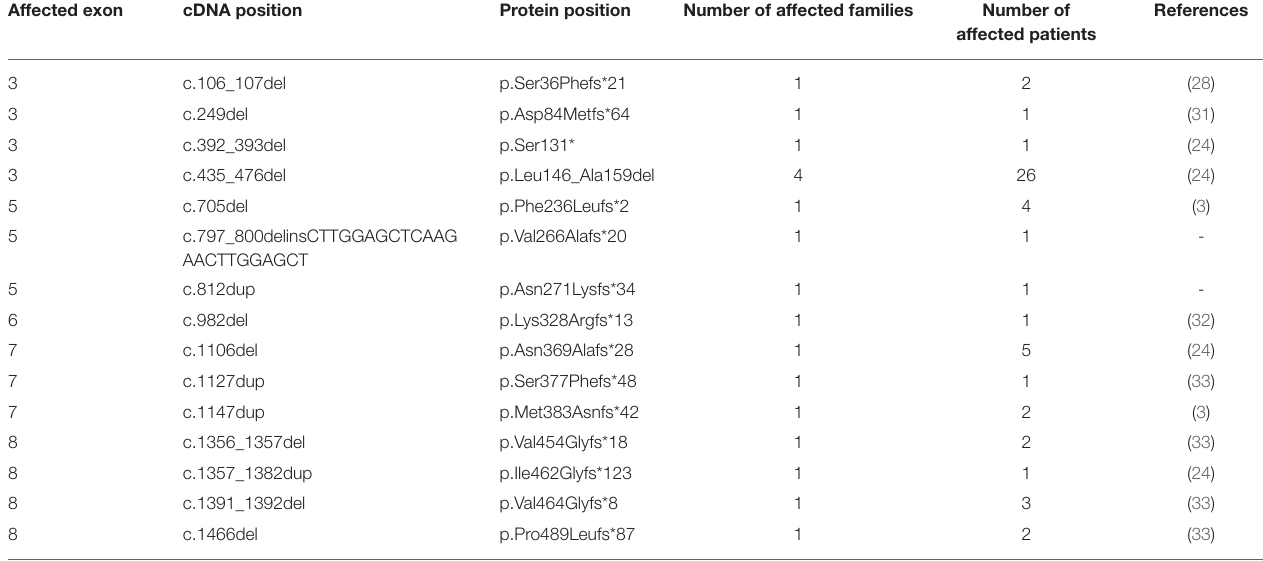
TABLE 3 | Small deletions/insertions/delins identified in the SERPING1 gene. Affected